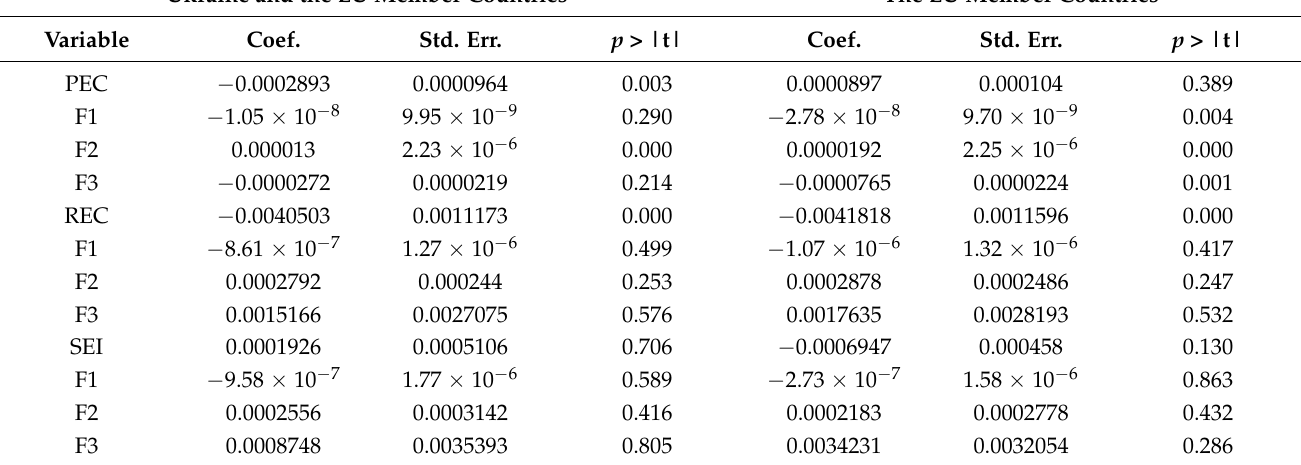
Table 4. The results of the calculation assessing β -convergence of energy efficiency indicators in the energy